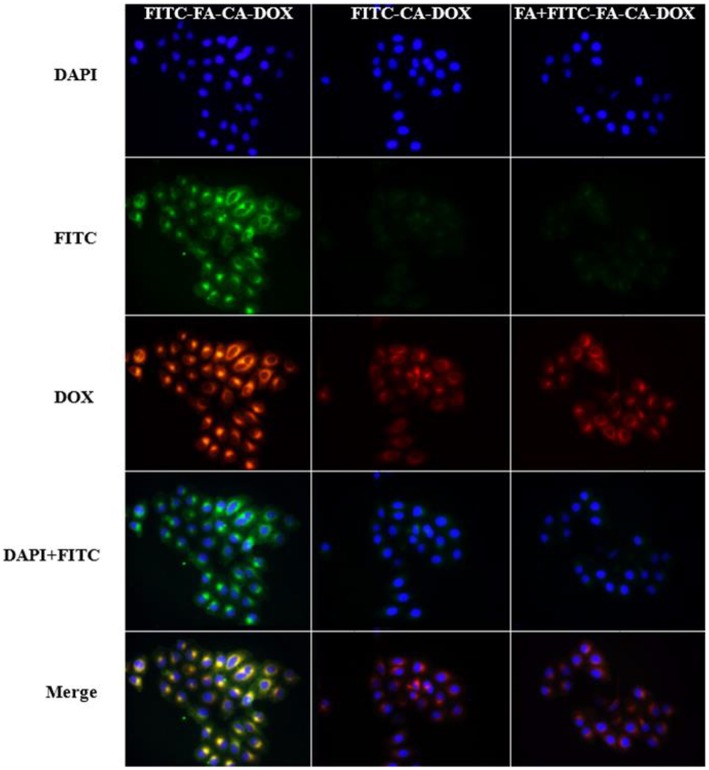
Inverted fluorescence microscope observation of intracellular internalization profiles of FITC-FA-CA-DOX, FITC-CA-DOX, and free FA
+
FITC-FA-CA-DOX micelles after incubation with HeLa cells. Blue fluorescence represents DAPI, green fluorescence represents FITC and red fluorescence represents DOX.